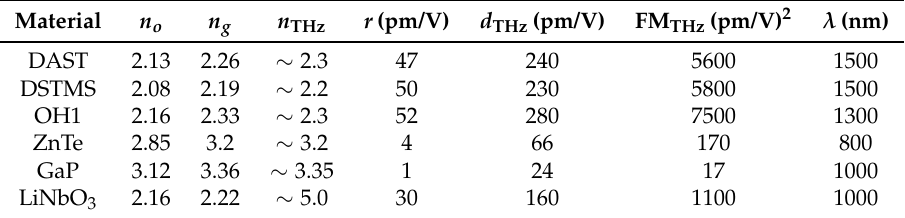
Table 2. Selection of organic and inorganic NLO materials that have been investigated for THz-wave generation and their most relevant parameters. Where possible, the parameters are given close to the optimal phase matching range: refractive index n o and the group index n g at the pump optical wavelength λ ; refractive index n THz in the THz range; the electro-optic coefficient r ; the NLO coefficient d THz for THz-wave generation according to Equation (17); the figure of merit FM THz for THz-wave generation according to Equation